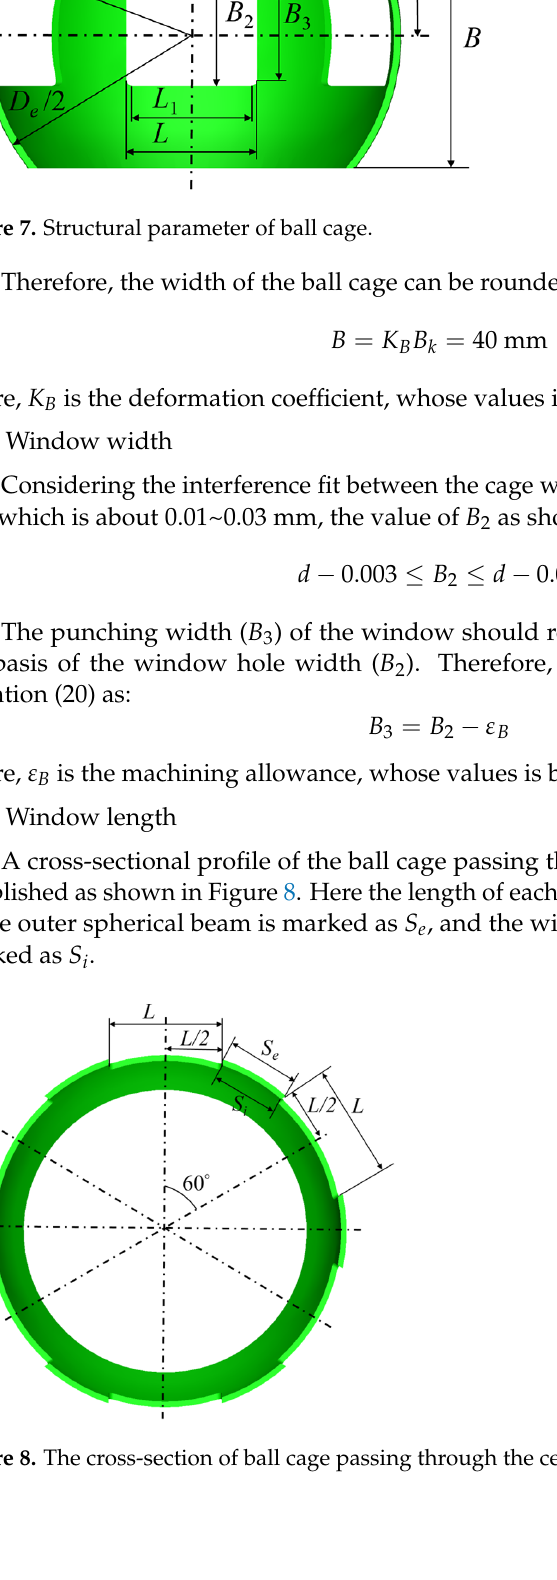
Figure 8. The cross-section of ball cage passing through the center of the sphere. According to Equations (15) and (16), the outer spherical diameter ( D e ) and the inner spherical diameter ( D i ) of the cage can be obtained. Then, the width of the outer spherical beam and the inner spherical beam can be solved as sin(30